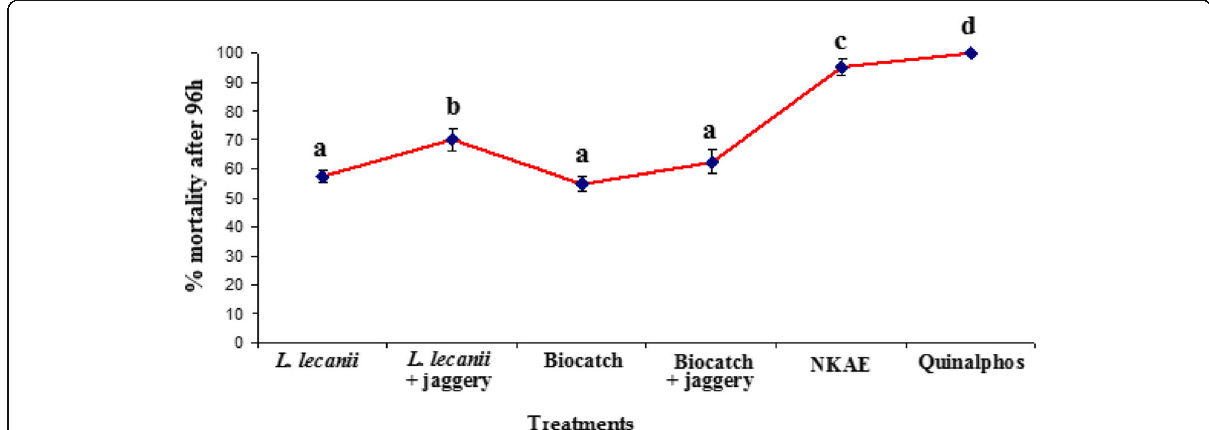
Fig. 2 Laboratory bio-efficacy of different treatments against tea thrips. Values represent cumulative percent mortality, means followed by the similar letter(s) in the columns are not significantly different at 5% by